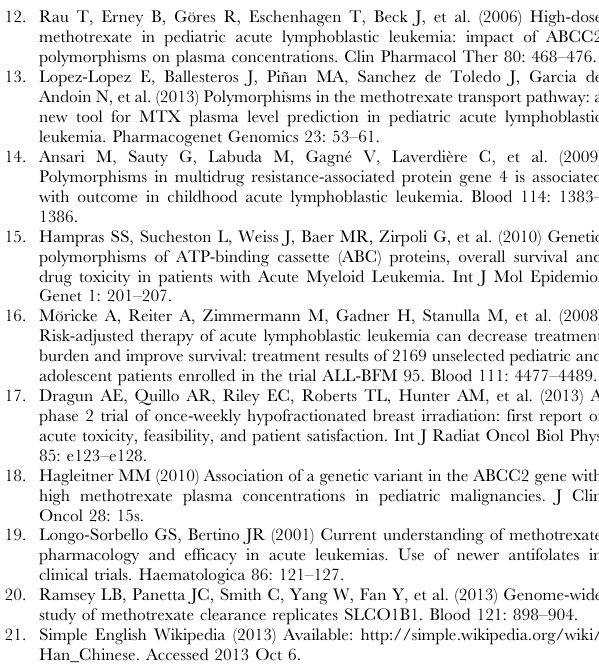
Table S1 Common Terminology Criteria for Adverse Events version